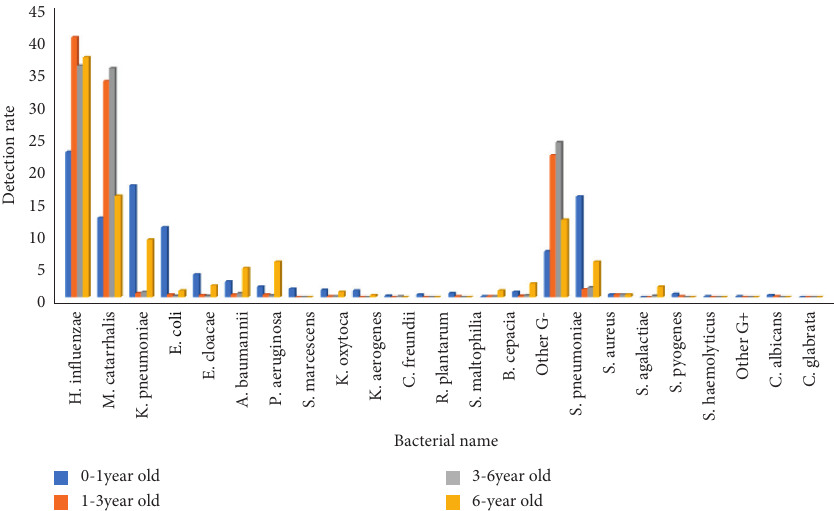
Figure 5: Detection rate of lower respiratory tract pathogens in different age groups from 2011 to 2020